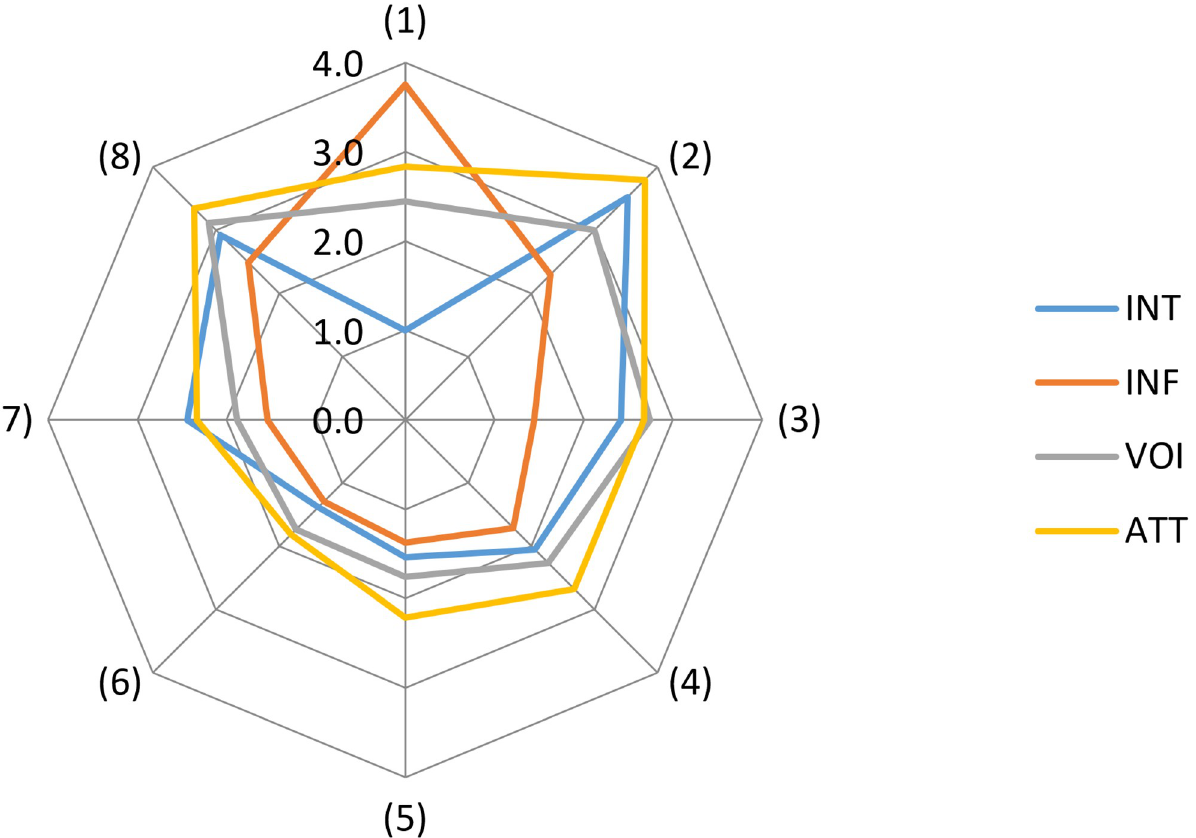
Fig 3. Mean of the four variables for all stakeholder